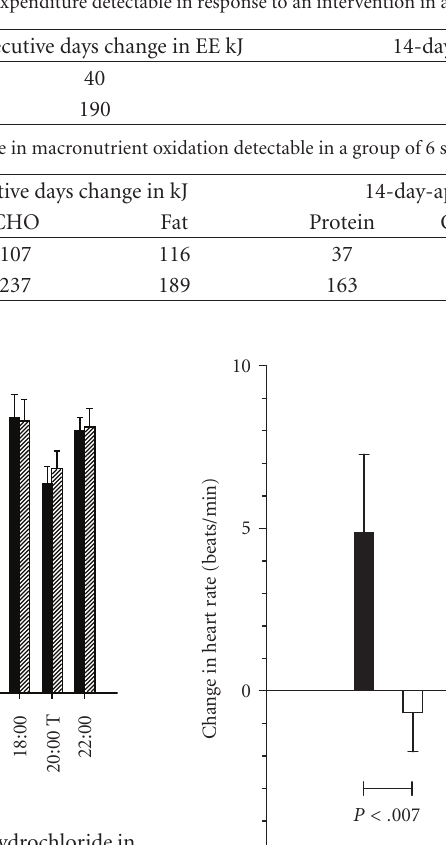
(a) The predicted change in energy expenditure detectable in response to an intervention in a group of 6 subjects.